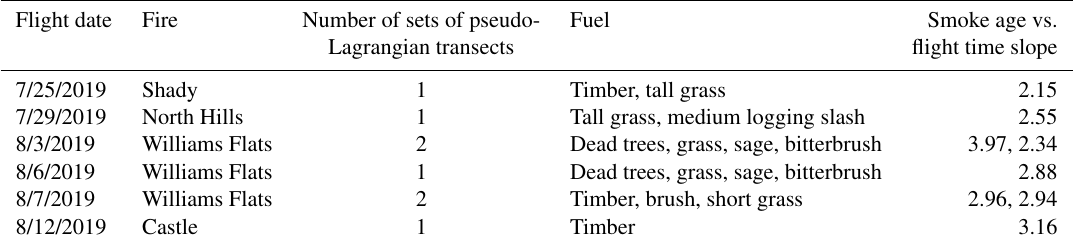
Table 1. Information on the fires used in analysis. Fuels are from the National Wildfire Coordinating Group (NWCG) incident reports (https://inciweb.nwcg.gov/, last access: 13 May 2022). Dates are given in the format month/day/year. Fire Number of sets of pseudo- Fuel Smoke age